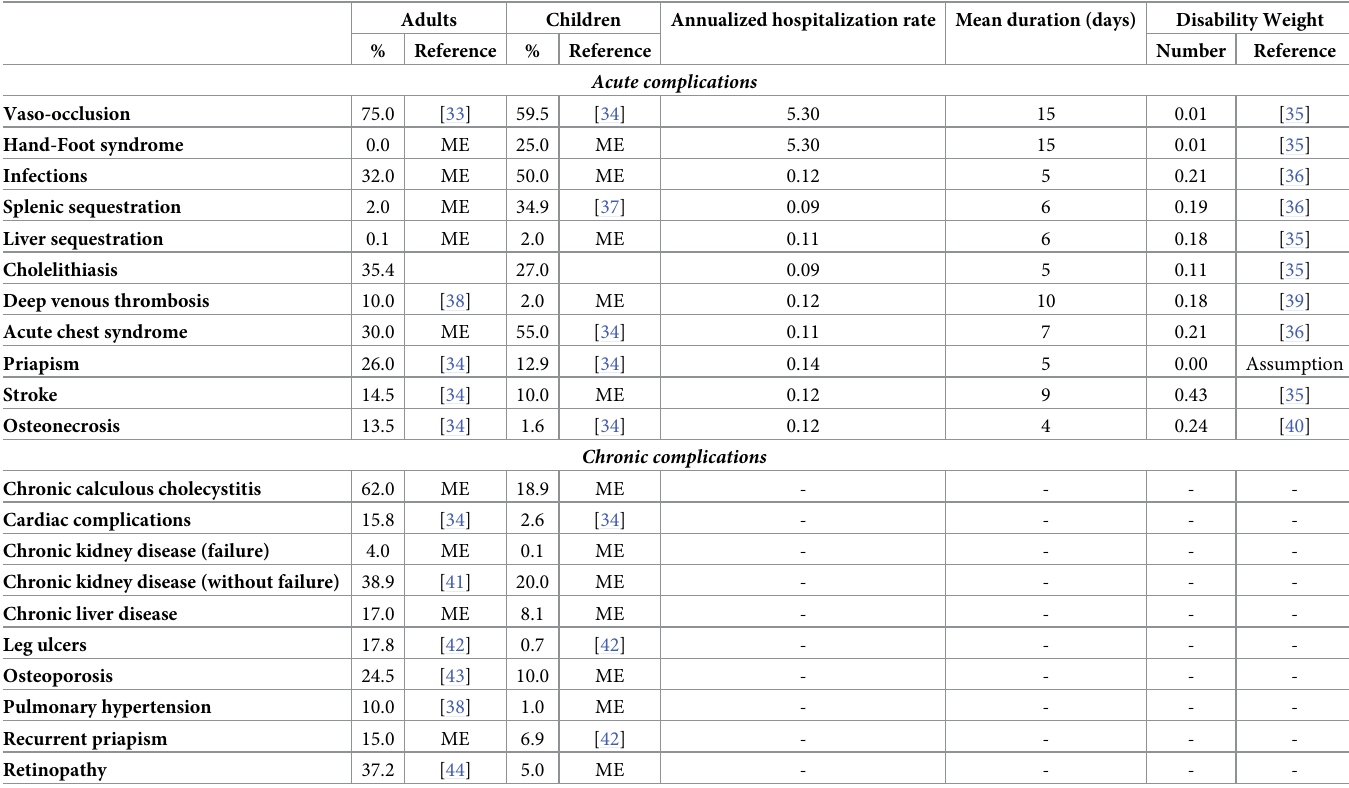
Table 1. Morbidity parameters (acute and chronic